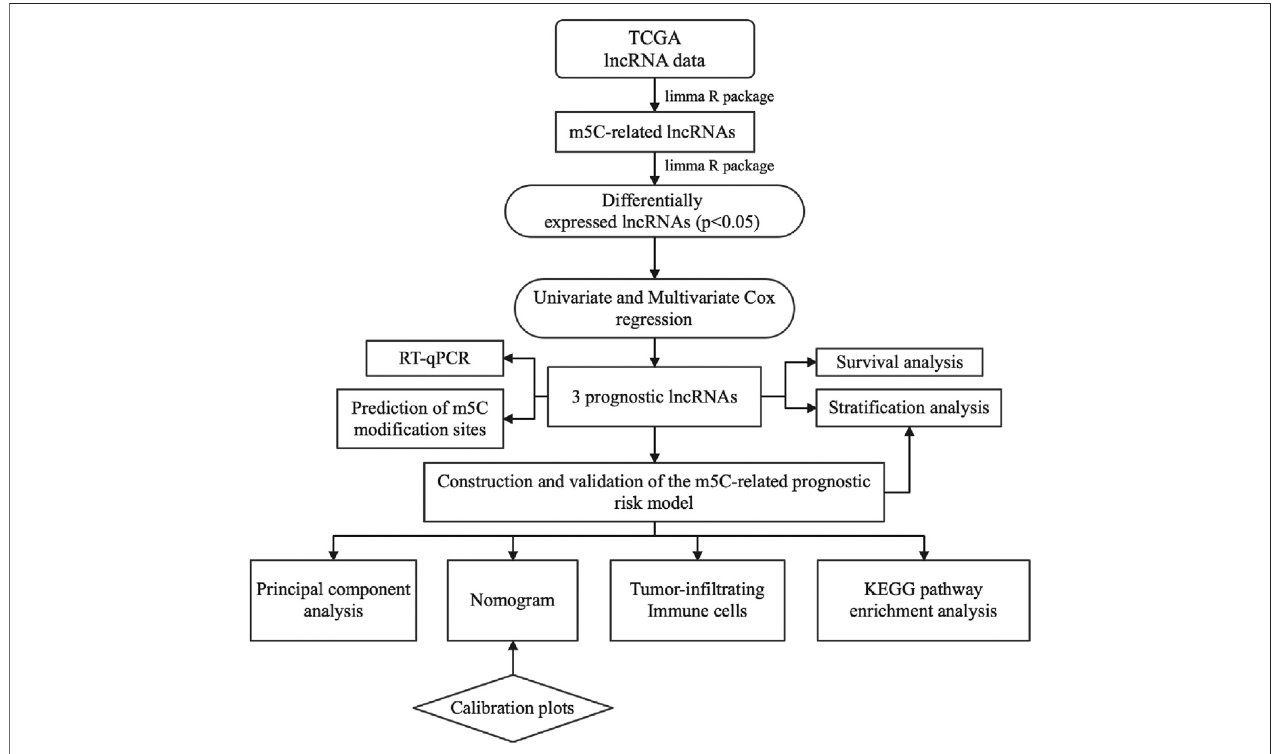
FIGURE 1 | Flowchart for establishing and evaluating prognostic risk